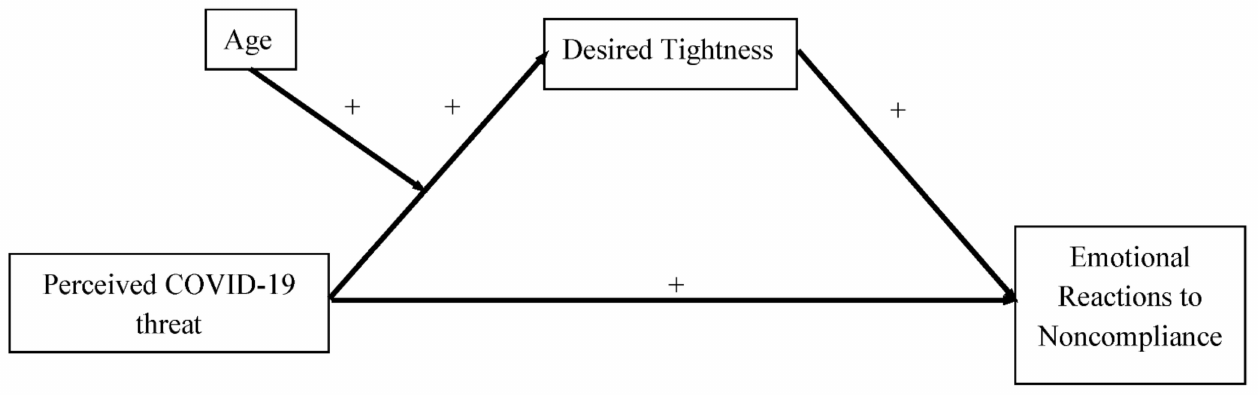
Figure 1. Hypothetical